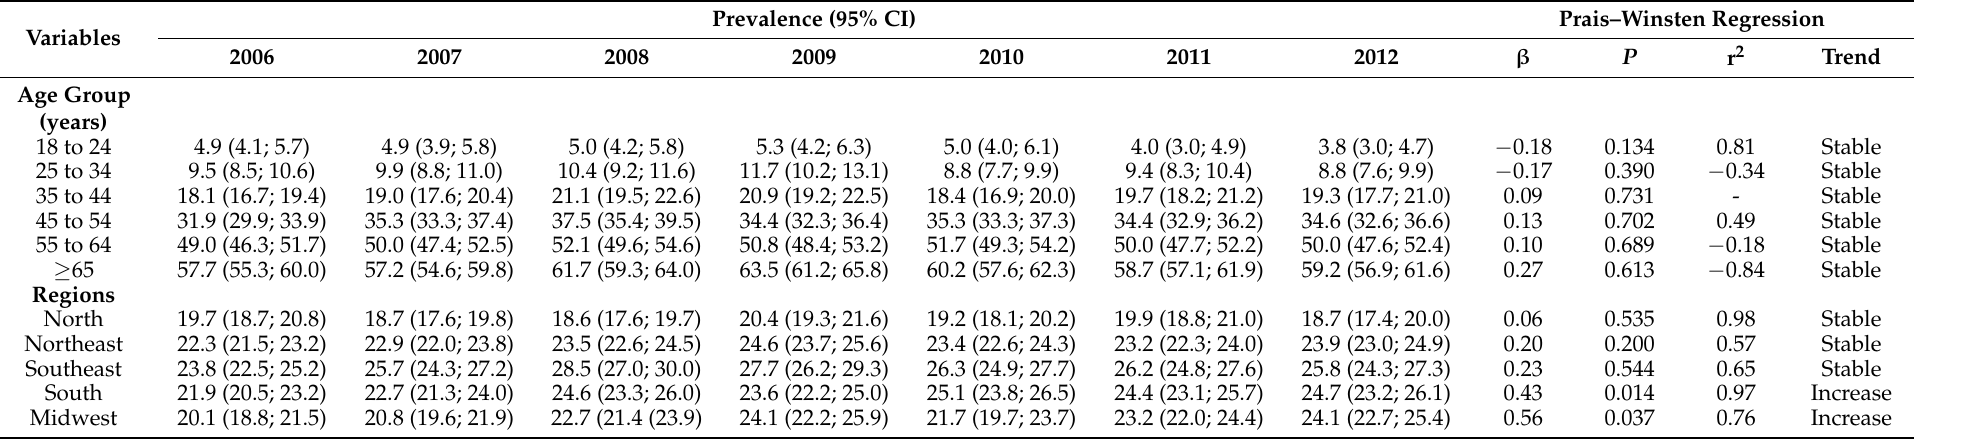
Table 3. Prevalence of systemic arterial hypertension in adults reporting previous medical diagnosis, stratified by age group and regions of Brazil between 2006 and